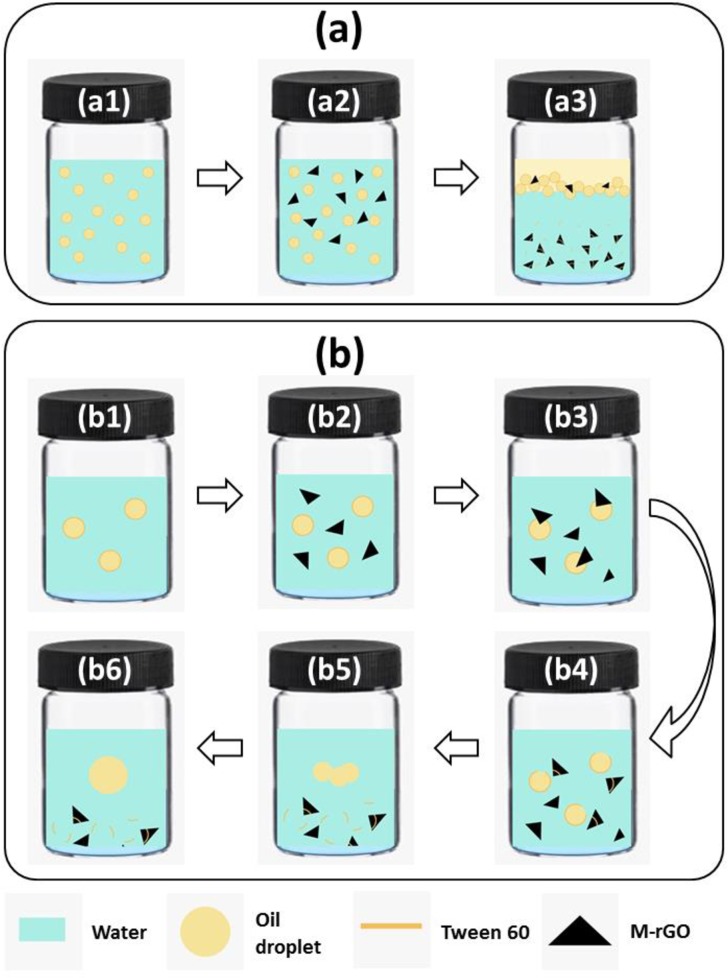
Schematic illustration of (a) the demulsification process and (b) the possible demulsification mechanism.